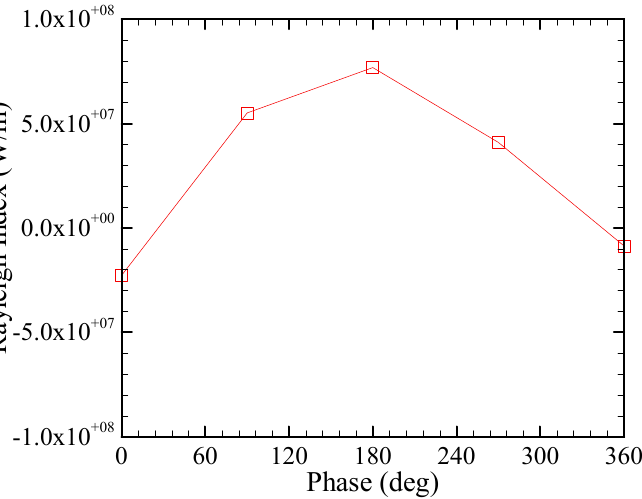
Figure 18. Rayleigh index averaged spatially over the analysis plane of injector B verses the phase in one period of the